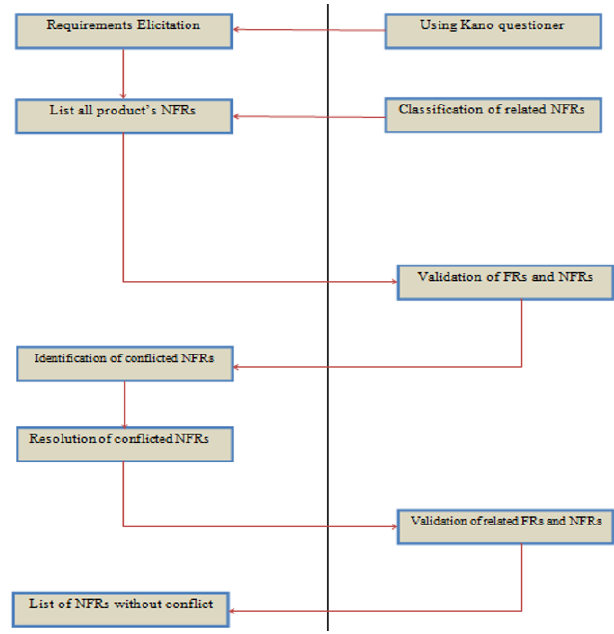
Figure 1 . Proposed